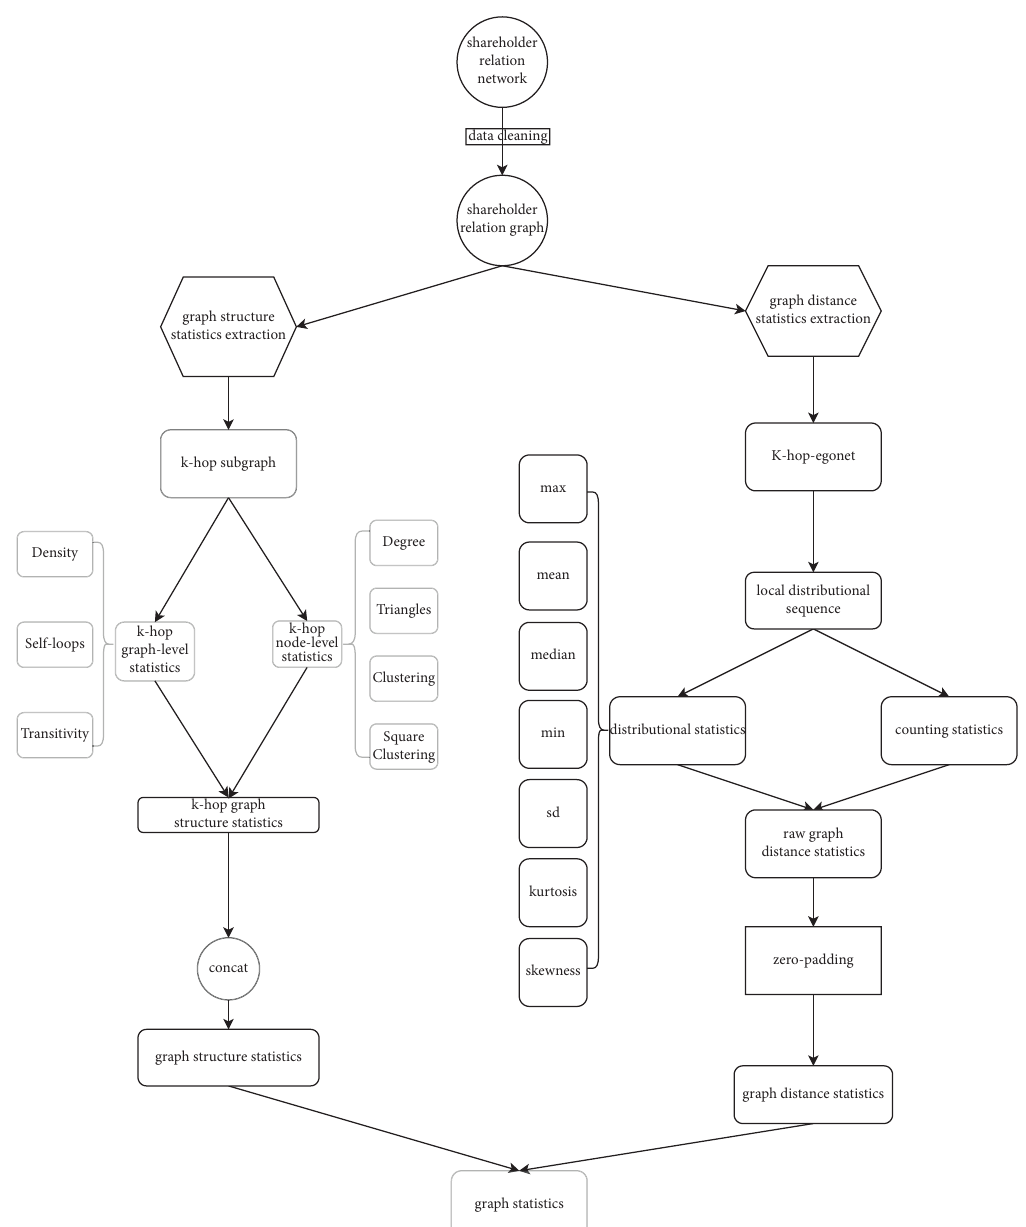
Figure 2: Extraction